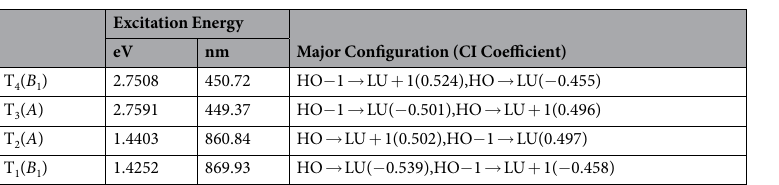
Excitation Energy